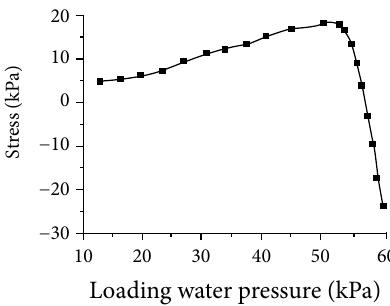
Figure 10: Stress change characteristics of monitoring points in the hydraulic loading stage.